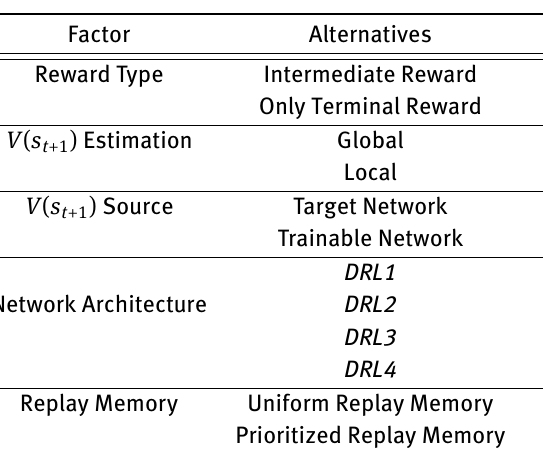
Figure 4: Confusion matrix for the classification of objectives from the Tell-Me-Dave corpus. Table 3: Different factors and their alternatives which are used to create a DRL